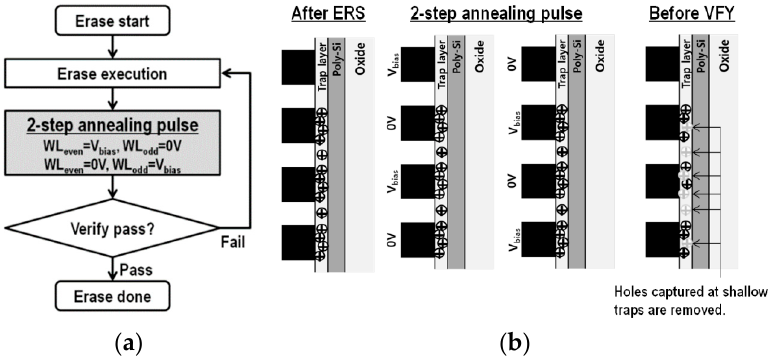
Figure 13. ( a ) Flowchart of erase operation using the two-step annealing pulse scheme. Reprinted/adapted with permission from Ref. [40], 2021, IEEE. ( b ) conceptual behavioral model of annealing pulse scheme. Reprinted/adapted with permission from Ref. [40], 2021, IEEE.